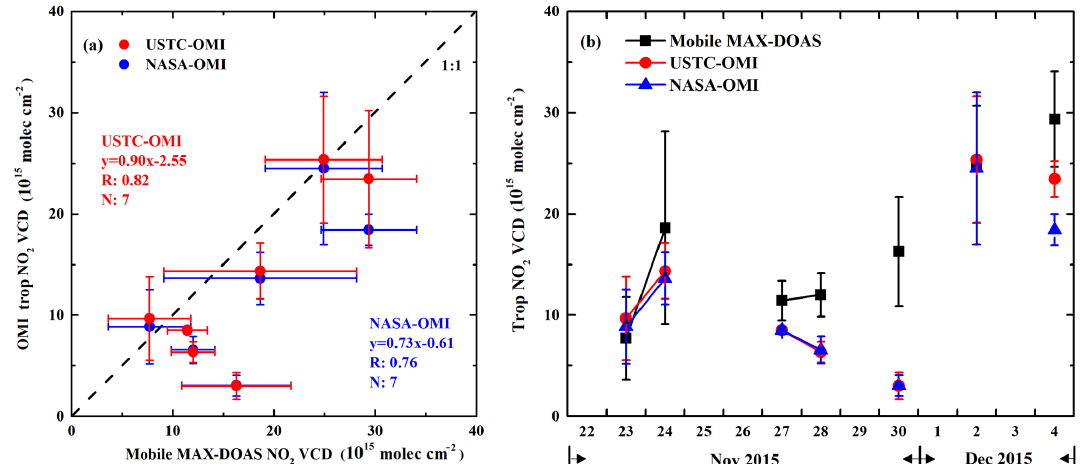
Figure 7. (a) Correlation analysis and (b) time series of tropospheric NO 2 VCDs measured by ship-based MAX-DOAS and OMI during the Yangtze River campaign. MAX-DOAS data (black marks) are temporally averaged around the USTC OMI and NASA OMI overpass time (red and blue marks, respectively), while the OMI data are spatially averaged within a 20km radius around the ship’s average position. The error bars show the 1 σ of ship-based MAX-DOAS and OMI